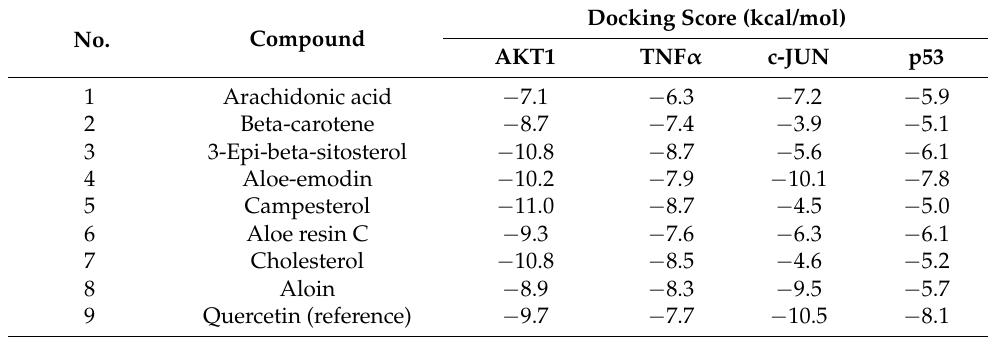
Table 2. Binding affinities between active components and core targets of Aloe vera . Docking Score (kcal/mol) No. Compound AKT1 TNF α c-JUN p53 1 Arachidonic acid − 7.1 − 6.3 − 7.2 − 5.9 2 Beta-carotene − 8.7 − 7.4 − 3.9 − 5.1 3 3-Epi-beta-sitosterol − 10.8 − 8.7 − 5.6 − 6.1 Aloe-emodin − 10.2 − 7.9 − 10.1 − 7.8 Campesterol − 11.0 − 8.7 − 4.5 − 5.0 6 Aloe resin C − 9.3 − 7.6 − 6.3 − 6.1 7 Cholesterol − 10.8 − 8.5 − 4.6 − 5.2 Aloin − 8.9 − 8.3 − 5.7 Quercetin (reference) −